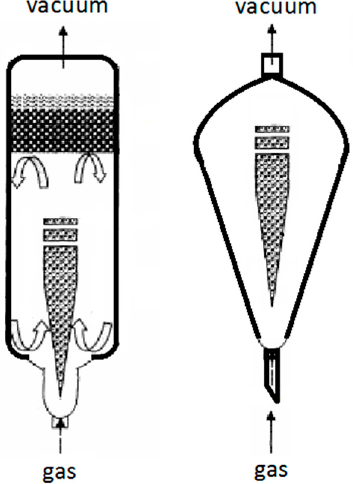
Figure 6. Schematic diagram of the HVBE apparatus